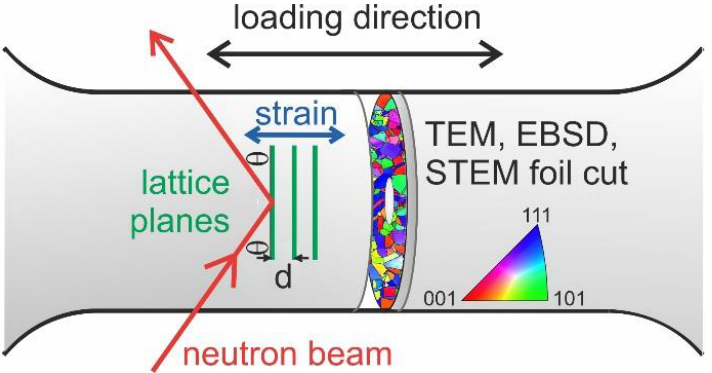
Figure 1. Schematic view of the investigated lattice planes by the neutron beam in relation to the direction of loading and introduced lattice strain of the tensile specimen. The thin electron transparent foils that were taken perpendicular to the loading direction were characterized microscopically using Transmission electron microscopy (TEM), Electron backscatter diffraction (EBSD), and scanning transmission electron microscope (STEM).